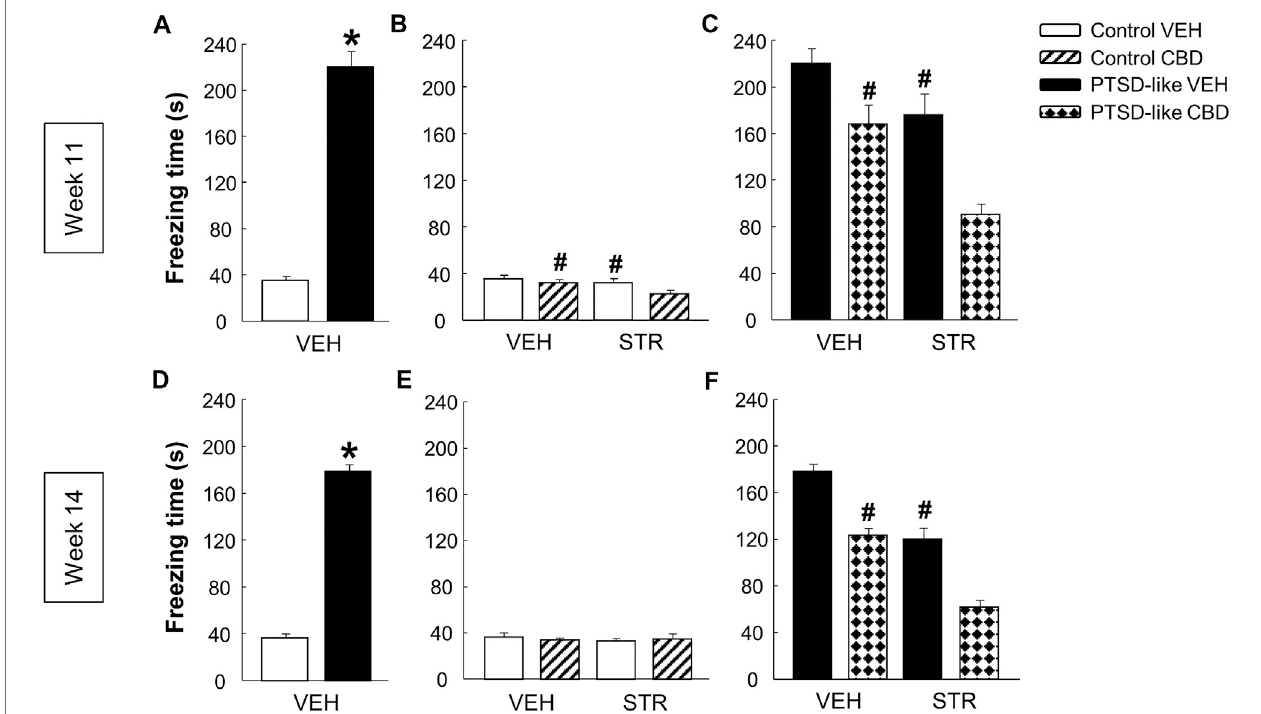
FIGURE 5 | Evaluation of fear-related memory at weeks 11 and 14. Analysis of the freezing time (s) by the fear conditioning paradigm between control and PTSD- like VEH-treated mice at week 11 (A) and week 14 (D) . Effects of acute (week 11) and chronic (week 14) administration of CBD (20 mg/kg, i.p.) and/or STR (10 mg/kg, p.o.), oritscorrespondingVEH, onthefreezingtime(s)ofcontrolmice (B,E) andPTSD-likemice (C,F) .Columnsrepresent themeansandverticallines ± SEM.*,Values from PTSD-like VEH-treated mice that are signi fi cantly different from control VEH-treated mice (Student ’ s t -test, p < 0.001). #, Values from CBD- or STR-treated groups that are signi fi cantly different from VEH-treated mice (Two-way ANOVA, p < 0.05). and, Values from CBD plus STR-treated mice that signi fi cantly different from CBD- and STR-treated control (Two-way ANOVA, p < 0.05) and PTSD-like mice (Two-way ANOVA, p < 0.001). Mice exposed to the PTSD-like model: N(VEH) (cid:2) 10, N(CBD) (cid:2) 10, N(STR) (cid:2) 9, N(CBD plus STR) (cid:2) 10; control mice: N(VEH) (cid:2) 10, N(CBD) (cid:2) 9, N(STR) (cid:2) 9, N(CBD plus STR) (cid:2) 10.